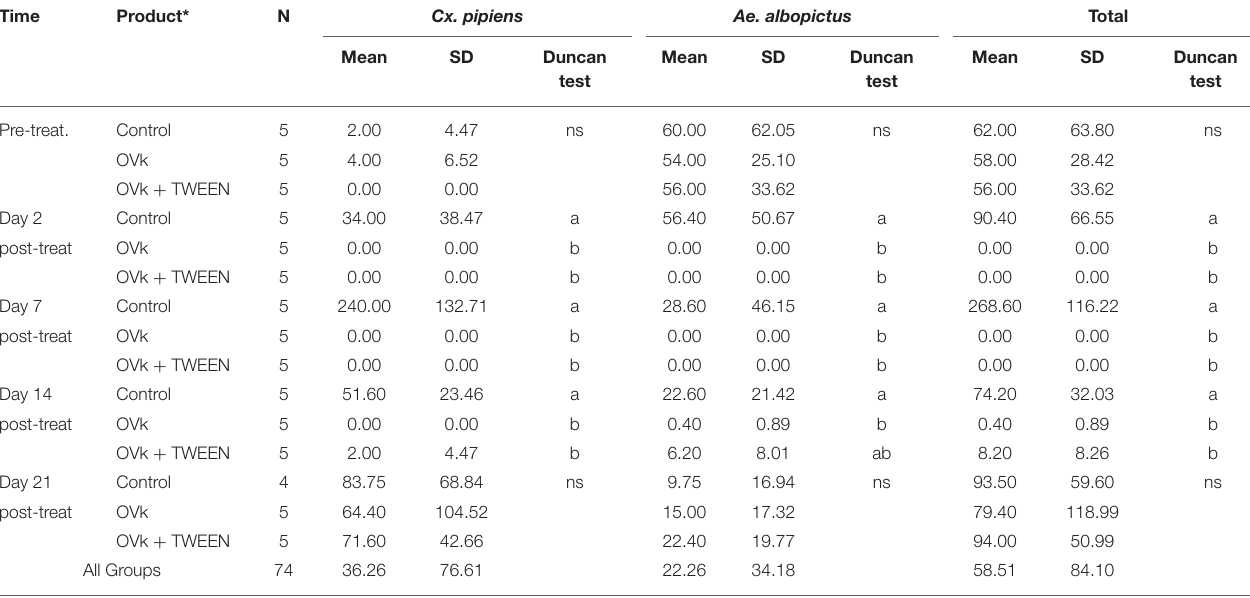
TABLE 8 | Mean number of Culex pipiens and Aedes albopictus larvae (L 1 -L 2 -L 3 -L 4 ) and pupae collected per aquatic net per road drain.